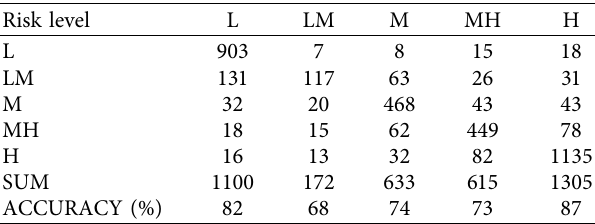
Figure 11: Overtaking situation: (a) and (b) show the spatial distribution of the risk level under various prediction horizons; (c) is the corresponding spatial distribution of the realistic risk level; (d) and (e) show the risk level statistics of each window under the two prediction horizons. (f) and (g) are the number of samples of each risk level in the five stages. (h) is the frequency of each risk level at various stages. Table 4: Confusion matrix under a prediction horizon of 30